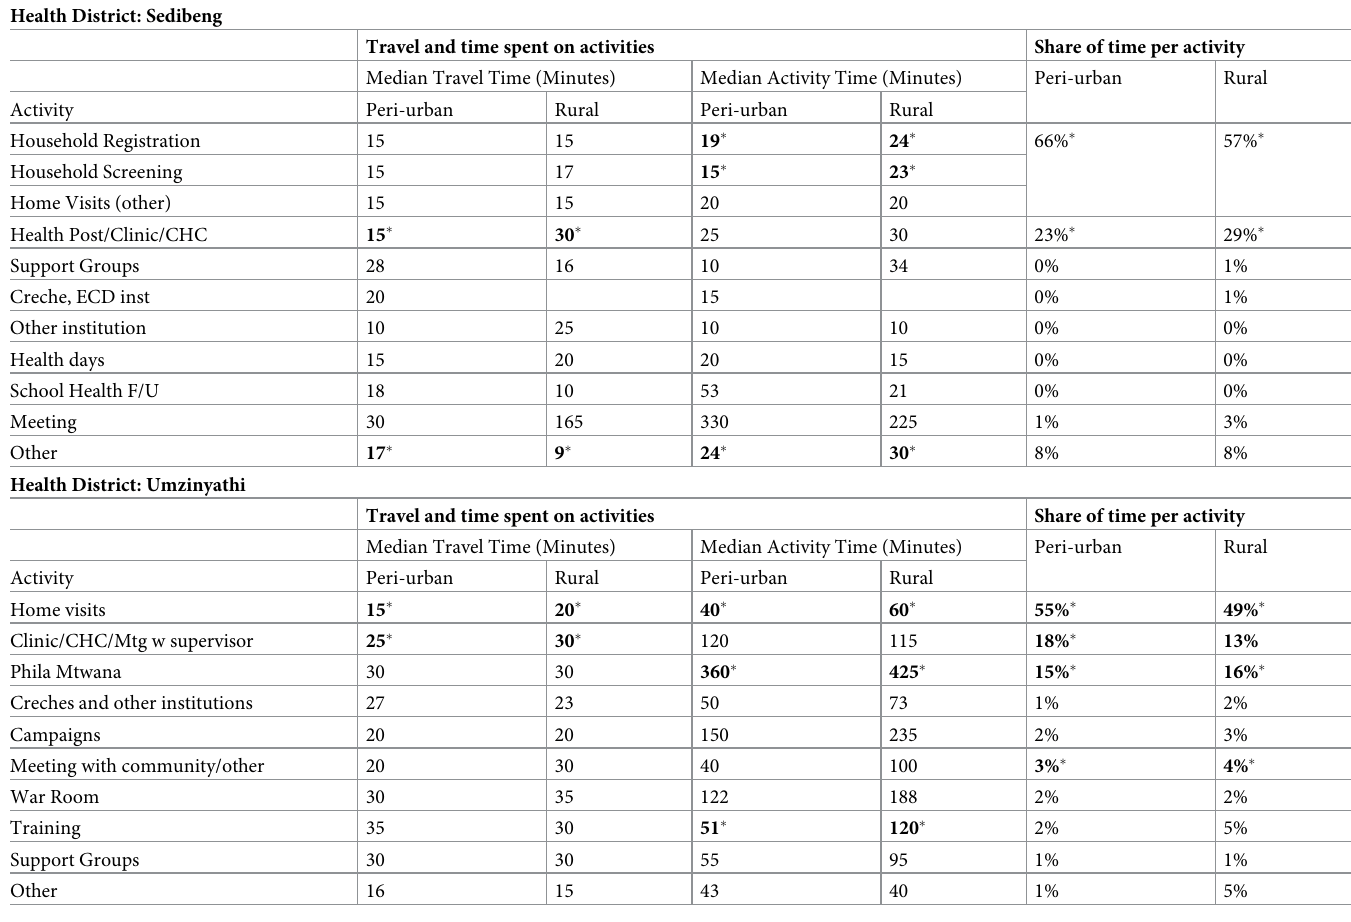
Median values (in minutes) are reported here for comparison purposes as the data was not normally distributed. Significance testing on the median travel and activity times were conducted through quantile regression for individual activities. Significance testing between the proportions of time spent on activities across geographical areas was conducted through a test of